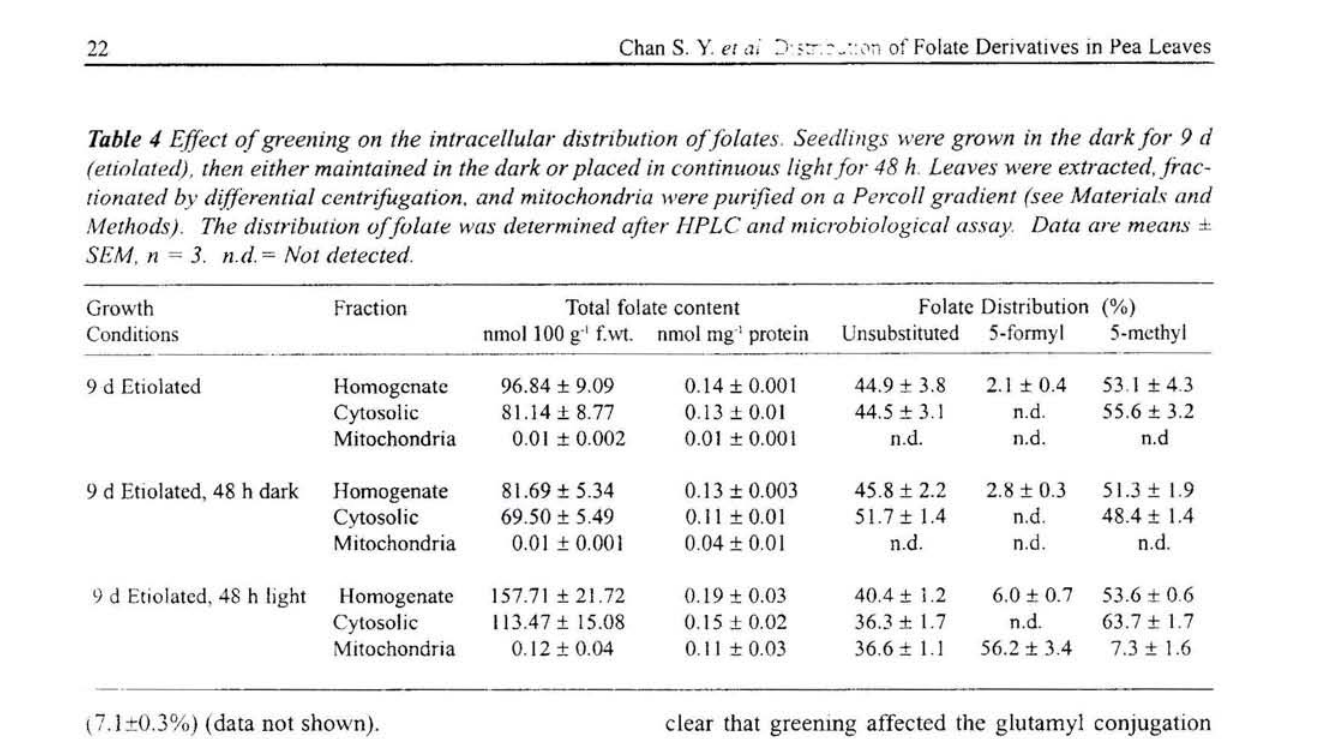
Table 4 Effect of greening on the intracellular distribution offolates. Seedlings were grown in the dark for 9 d (etiolated), then either maintained in the dark or placed in continuous lightfor 48 h. Leaves were extracted, frac- tionated by differential centrifugation, and mitochondria were purified on a Percoll gradient (see Materials and